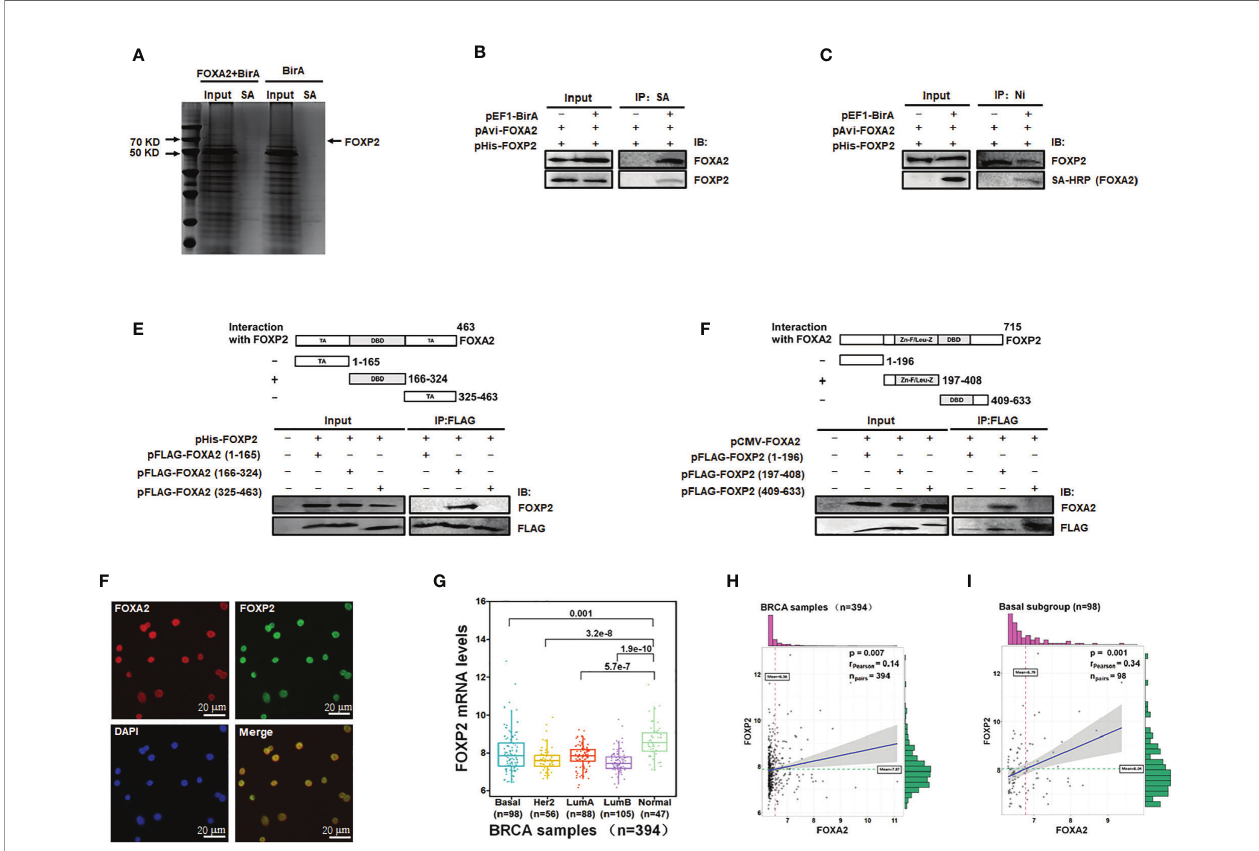
FIGURE 1 | Identi fi cation of FOXA2-interacting transcription factor FOXP2 in breast cancer cells. (A) The lysates of MCF-7 cells transfected with pAvi-FOXA2, pEF1- BirA, or both, were incubated with streptavidin resin. The pull-down proteins were separated by PAGE and visualized with coomassie brilliant blue staining. The position of FOXP2 was pointed out in the lane of the FOXA2+BirA sample on the gel. (B, C) The interaction between FOXA2 and FOXP2 in cells. The lysates of cells transfected with pAvi-FOXA2 and pHis-FOXP2 or pEF1-BirA, were pulled down with streptavidin resin (B) or Ni beads (C) . Western blotting was performed with anti- FOXA2 antibody, anti-FOXP2 antibody, or streptavidin-conjugated HRP (SA-HRP) respectively. (D, E) Mapping the regions mediating FOXA2-FOXP2 interaction in the proteins. The lysates of cells transfected with pHis-FOXP2 plus one of expressing plasmid vectors containing Flag-tagged FOXA2 1-165aa, 166-324aa, and 409- 633aa (D) , or the lysates of cells transfected with pCMV-FOXA2 plus one of expressing plasmid vectors containing Flag-tagged FOXP2 1-196aa, 197-408aa, 325- 463aa (E) , were immunoprecipitated with anti-Flag antibody. Western blotting was performed with anti-FOXP2 antibody, anti-FOXA2 antibody, or anti-Flag antibody respectively. The top panel showed a schematic representation of the regions in FOXA2 protein (D) and FOXP2 protein (E) . (F) The interaction of endogenous FOXA2 and FOXP2 was detected by the immuno fl uorescent microscopy in MCF-7 cells. The staining for FOXA2 (red), for FOXP2 (green), for DAPI (blue), and the merge of the FOXA2 and FOXP2 staining were shown. The cells were pictured by TE2000S (Nikon, 200×). (G) The levels of FOXP2 in the four subgroups (Basal, Her2, LumA, and LumB) of breast cancer and normal breast tissue in the clinical breast cancer samples (the BRCA data set, n=394). (H, I) The gene expression correlation analysis of FOXA2 and FOXP2 in the BRCA data set (n=394) (H) and in the Basal subgroup (n=98) (I) were executed by using ggstatsplot package through R project. The pink and green histograms represented the distribution of BRCA samples based on the levels of FOXA2 and FOXP2 expression